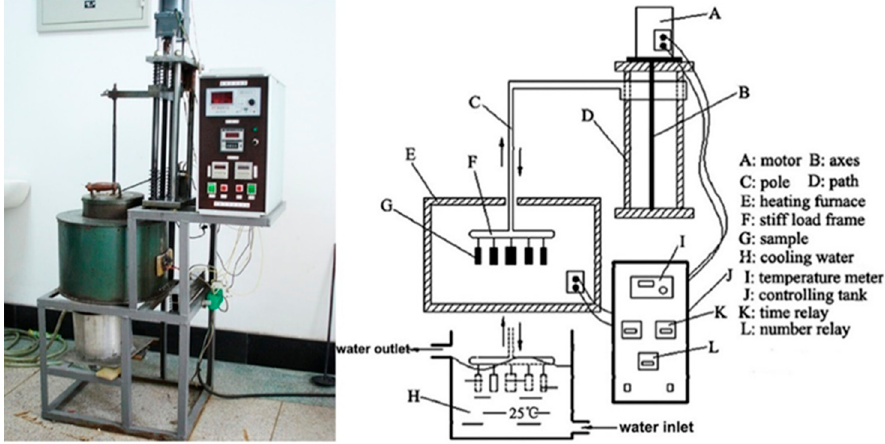
Figure 5. Shape and test process of the thermal fatigue testing machine.